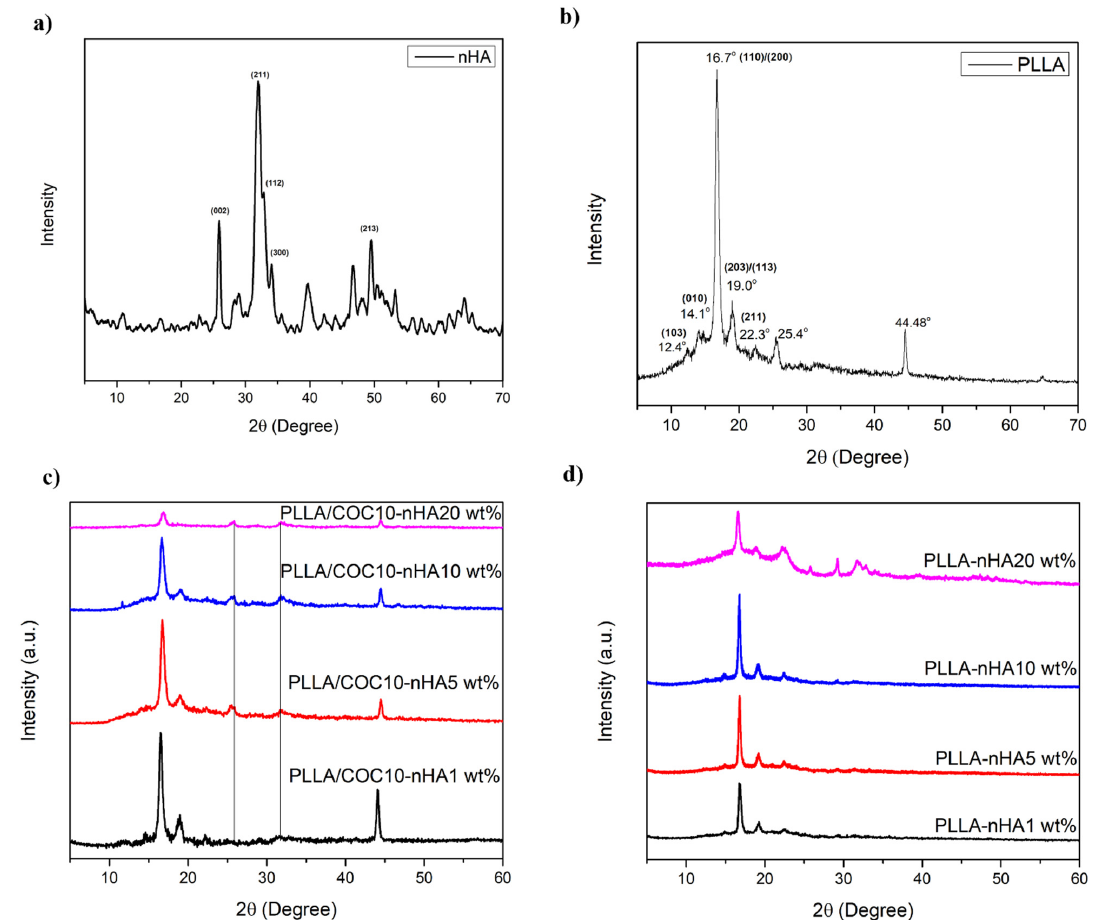
Figure 2. XRD of ( a ) nHA, ( b ) PLLA, ( c ) PLLA/COC10-nHA nanocomposites, and ( d ) PLLA/nHA nanocomposites. Nanocomposites had nHA in 1 wt%, 5 wt%, 10 wt%, and 20